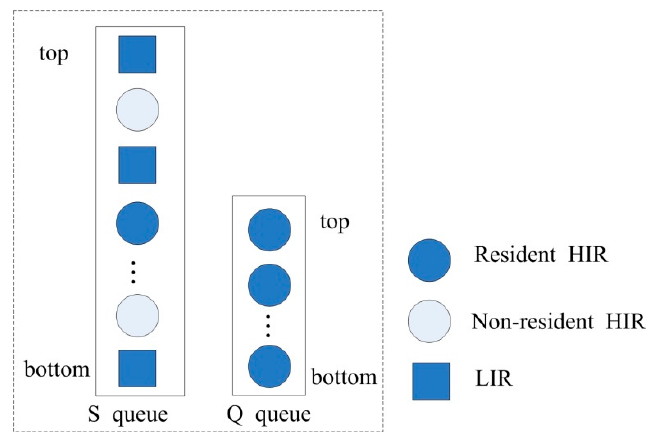
Figure 2. Architecture of LIRS (Low Inter-reference Recency Set) (including the S queue and Q queue).